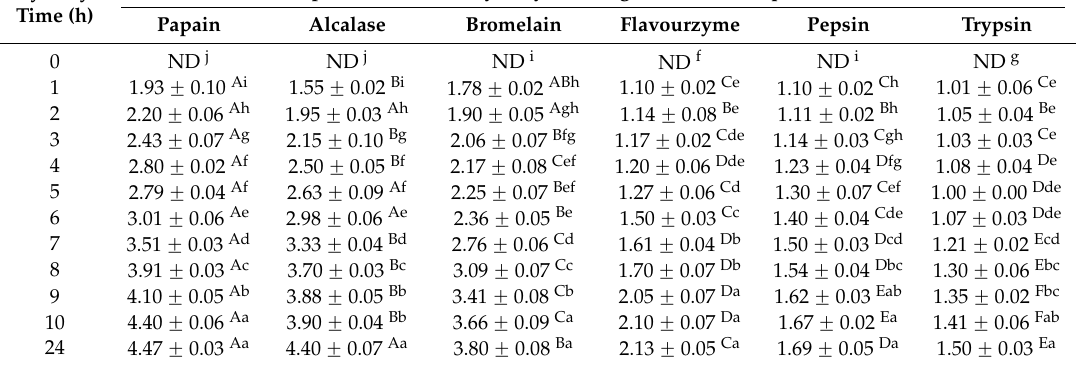
Table 1. Changes in peptide contents as a function of time during hydrolysis of A. lecanora with various proteases as monitored by the OPA